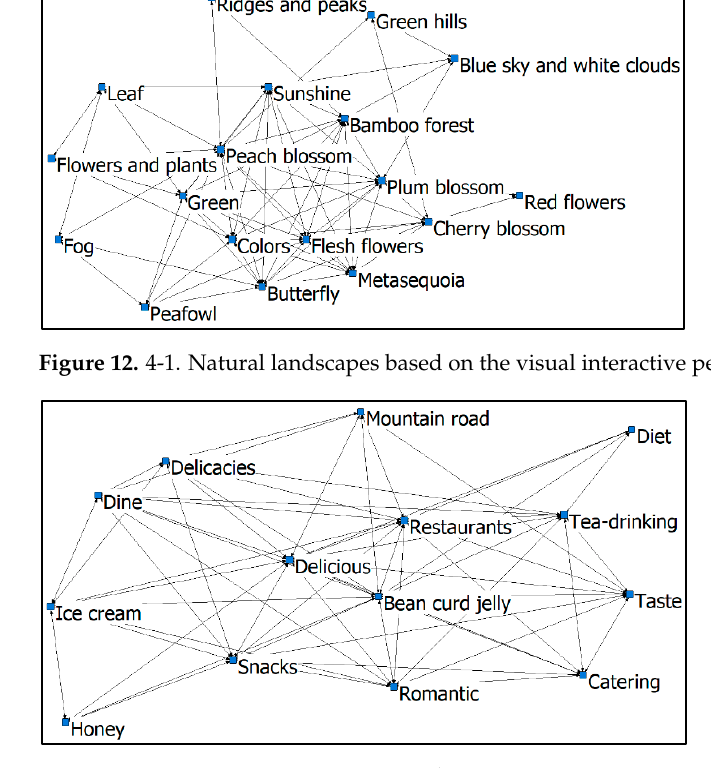
Figure 13. 5-1. Gustatory perception and experience activities.